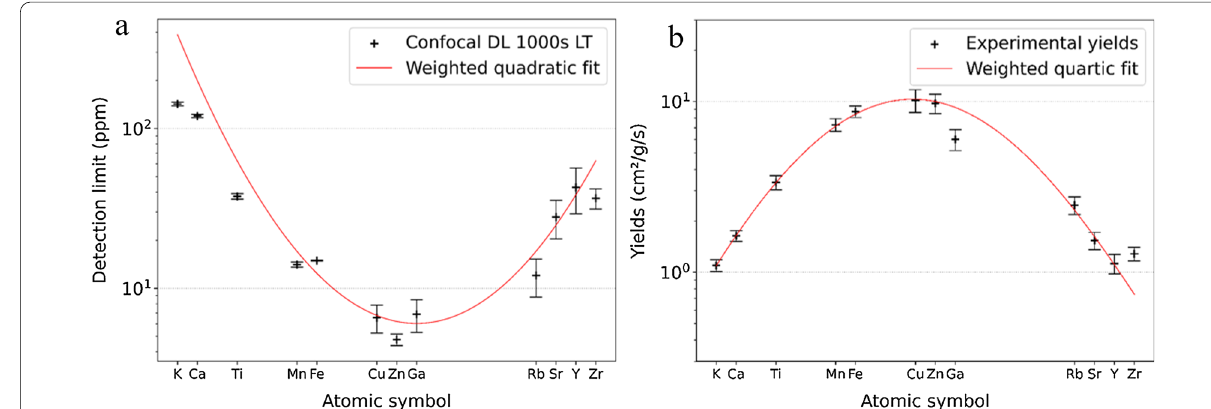
Table 1 Experimental and interpolated Monte Carlo‑based in terms of quantitative results. Si is not included as its yields (cm 2 /g/s) of ATHO‑G reference experimental yield calculation was not reliable; there- fore, it was not possible to reliably interpolate the experi- Experimental yields Interpolated MC‑based yields mental yield values between Si and K. The interpolated Elemental yield Standard Elemental yield Standard MC-based yields (50,000 simulations) are presented in deviation deviation Table 1. The corresponding elemental yield distribu- tion histograms for Fe, Cu, Zn and Ga are presented in Fig. 7. The shape of these curves is primarily Gaussian- like which can be explained by the large number of inde- pendent (random) variables influencing the calculated concentration values, hence approaching Gaussian distri- bution as a result of the central limit theorem (CLT). The distribution is also influenced by the Poisson distribution used for the perturbation of the ATHO-G spectral line intensities during the variance analysis. The concentration values and standard deviations (resulting from 50,000 trials in the variance analysis) calculated from the Ryugu point analyses (Figs. 3, 4) for the matrix (points #1 and #6), magnetite (points #2, #3, 7.144 #5 and #14) and pyrrhotite (point #11) are presented in Table 2, and for the dolomite (points #4, #9, #10 and #13), apatite (points #7 and #8) and breunnerite (point #12) in Table 3. ‘nd’ means ‘not detected’ which notes the fact that the element was either not present or present below DL. “Others” denotes the combined weight fraction of all major/minor elements whose concentration values could not be determined accurately by SEM–EDX or SR- XRF analysis. For all confocal point measurements this majority of elemental yields, being either underestimated mostly consists of oxygen (O), for the matrix points this or overestimated, respectively. The deviation between the is extended with the elements below Si (Z < 14). To itera- interpolated yield curve and the experimental elemental tively update µ ρ ,total in the quantification method, the yields can indicate increased uncertainties for Ga and Zr